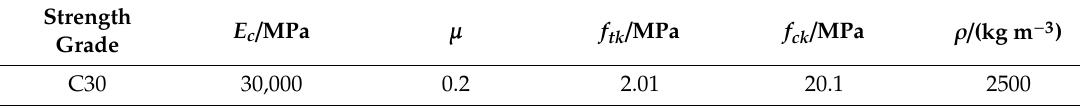
Table 4. Physical and mechanical parameters of the steel.